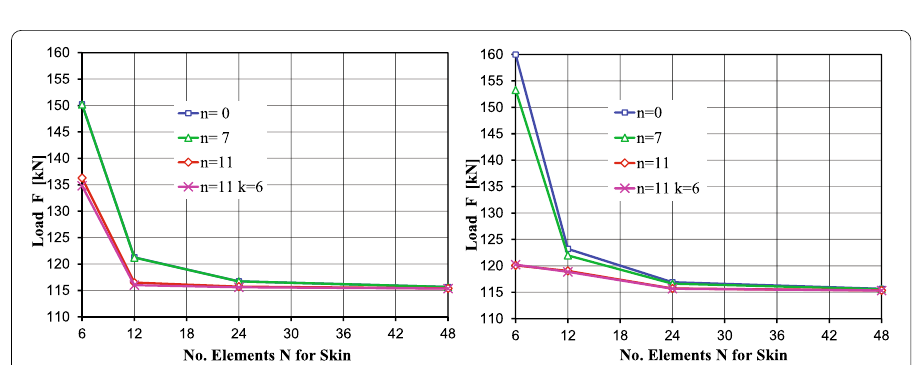
Fig. 40 Convergence behavior of the external load for a prescribed displacement w = 400 mm versus N and parameters n,k for the regular mesh (left) and the distorted mesh